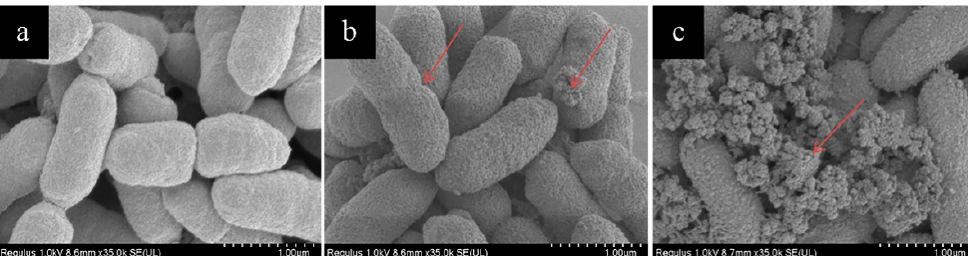
Figure 2. FE - SEM images of P. deceptionensis CM2 cells with SAEW treatment: ( a ) control cells, ( b ) cells treated with SAEW for 15 s, ( c ) cells treated with SAEW for 60 s.